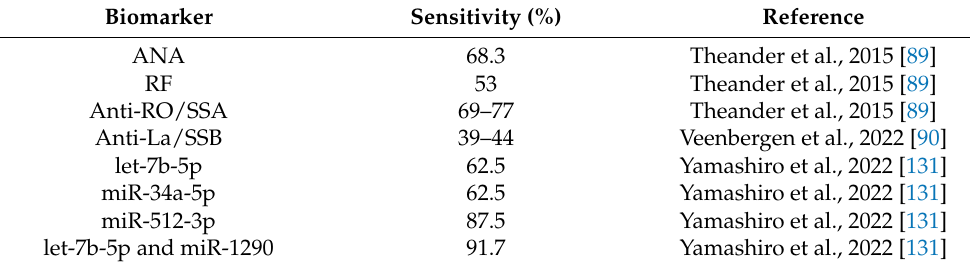
Table 2. Comparison of the diagnostic performance of exosomal